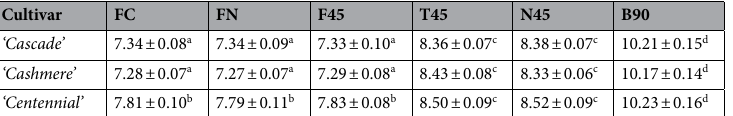
Table 1. Mean internode width (mm) of main bine internodes between node 20 and 40. Control free to climb at 90° (FC), free to climb a strand of 90° netting (FN), free to climb twine at 45° (F45), touch on twine at 45° slope (T45), touch on a single strand of trellis netting at 45° slope (N45), and 90° internode bending on netting at a 45° mean slope (B90). Standard deviation terms are reported as standard deviation of the difference of the means for cultivars ‘Cascade’ (n = 6), ‘Centennial’ (n = 6), and ‘Cashmere’ (n = 6). Different letters indicate significant difference among treatments ( P < 0.05).